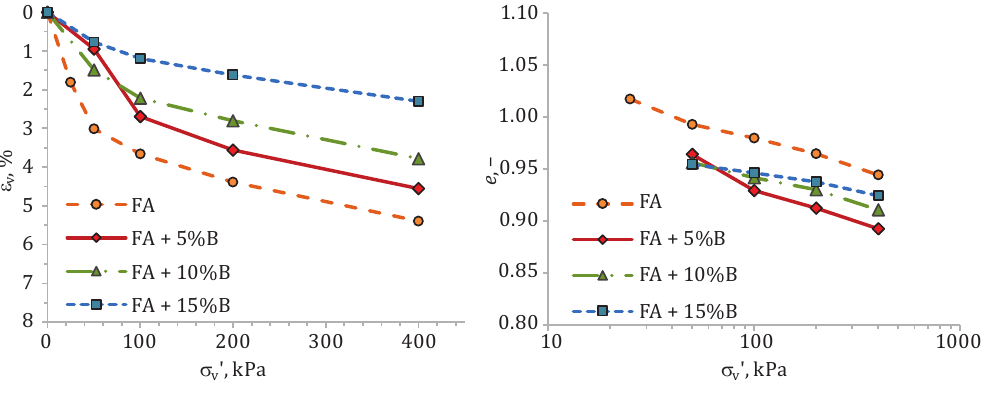
Figure 3. Vertical strain ε v versus pressure σ v ’, and void ratio e versus